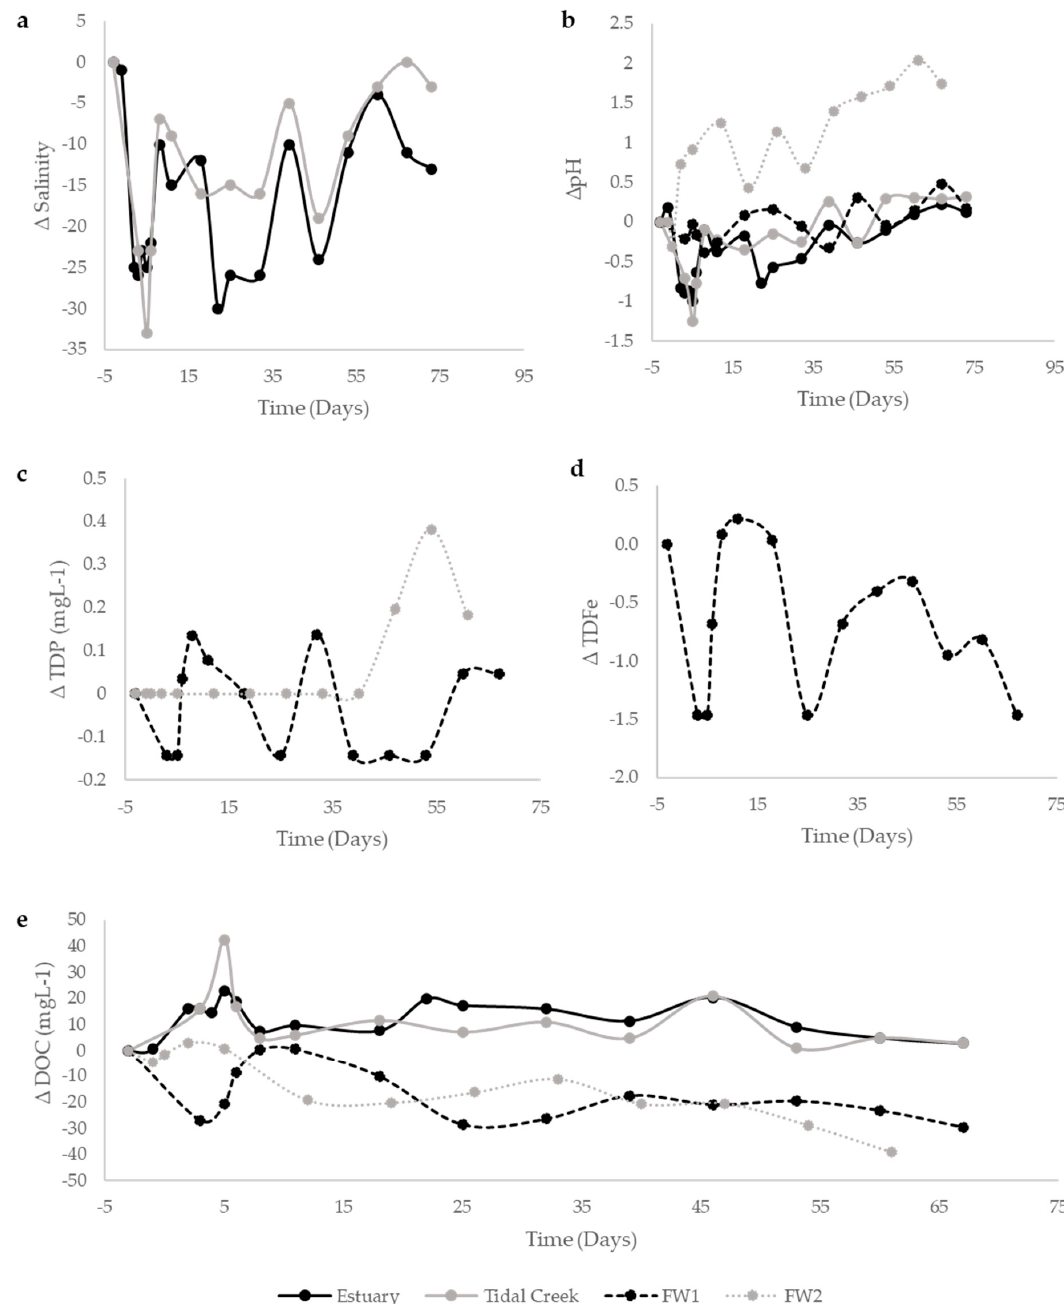
Figure 9. Measured concentrations for changes in ( a ) salinity, ( b ) pH, ( c ) total dissolved phosphorus, ( d ) total dissolved iron, and ( e ) dissolved organic carbon at estuary, tidal creek, freshwater 1, and freshwater 2 locations from initial concentrations (collected on 7 September 2017). All values were normalized to time point 0 values to display the di ff erences from initial conditions over time. Salinity was 0 psu across all measured time points at freshwater 1 and 2 sites, and total dissolved phosphorus and iron concentrations were below the minimum detection limit at the estuary and tidal creek locations. Hurricane Irma passed through the study site 3 on day 3 of the study.